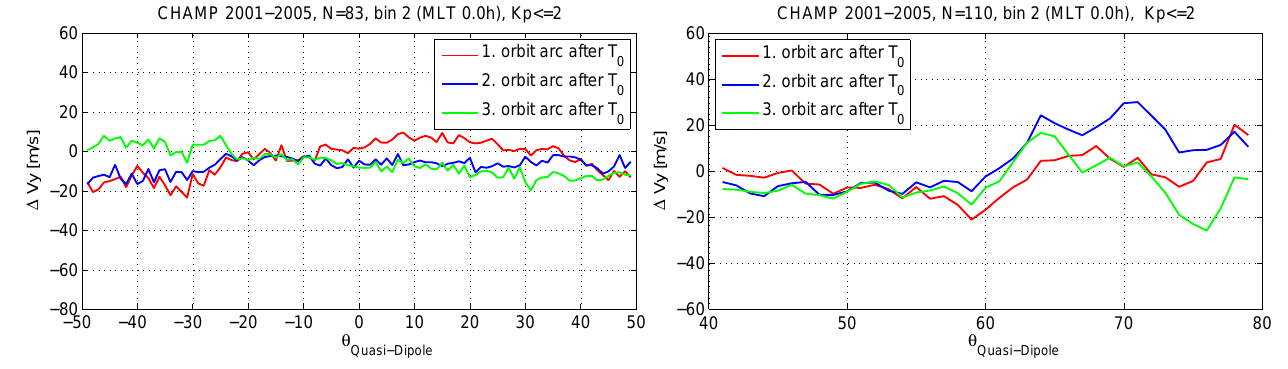
Fig. 10. same as Fig. 9, but for low magnetic activity (Kp ≤ 2). Calculated mean MLT: 24h.